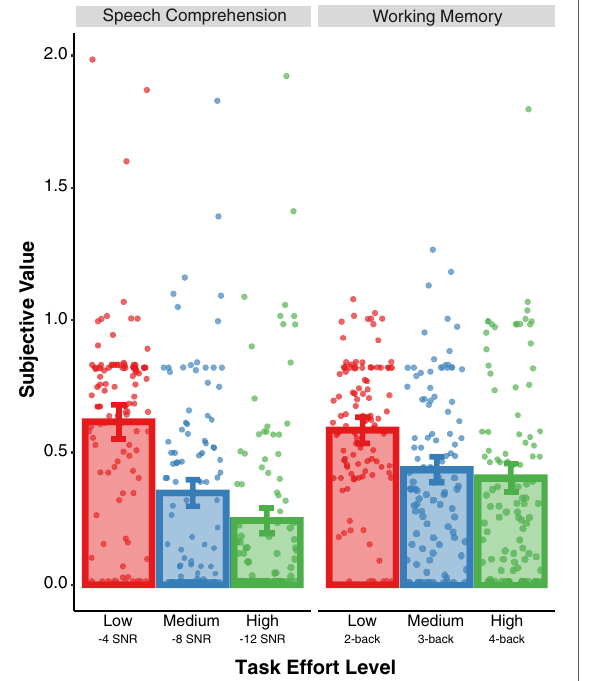
4 dB SNR; medium − 12 dB SNR) on −